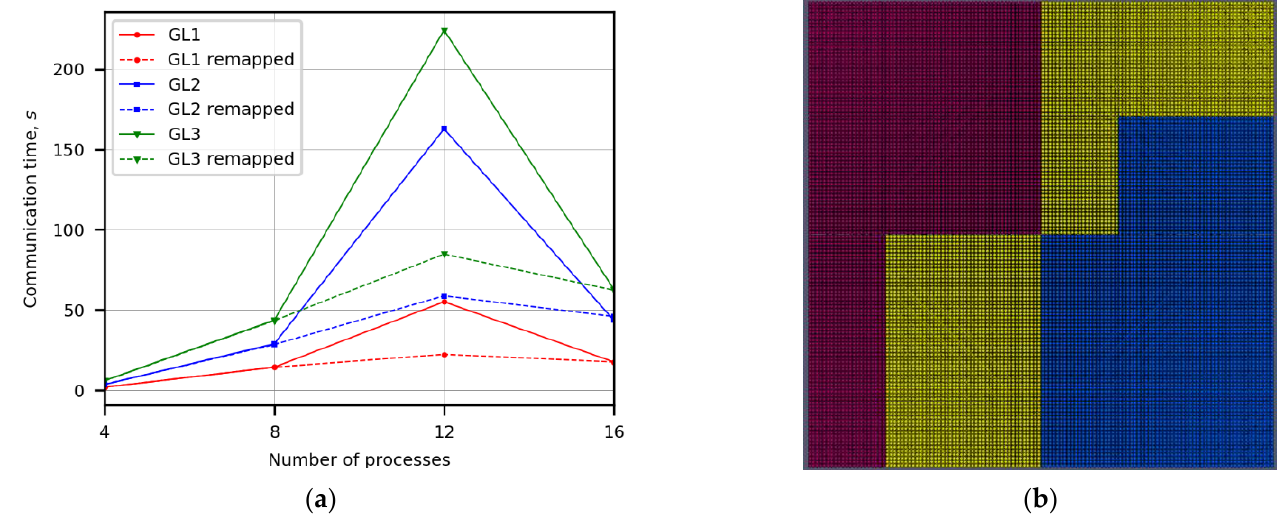
Figure 5. Communication time ( a ) and default particle distribution among three nodes ( b ).